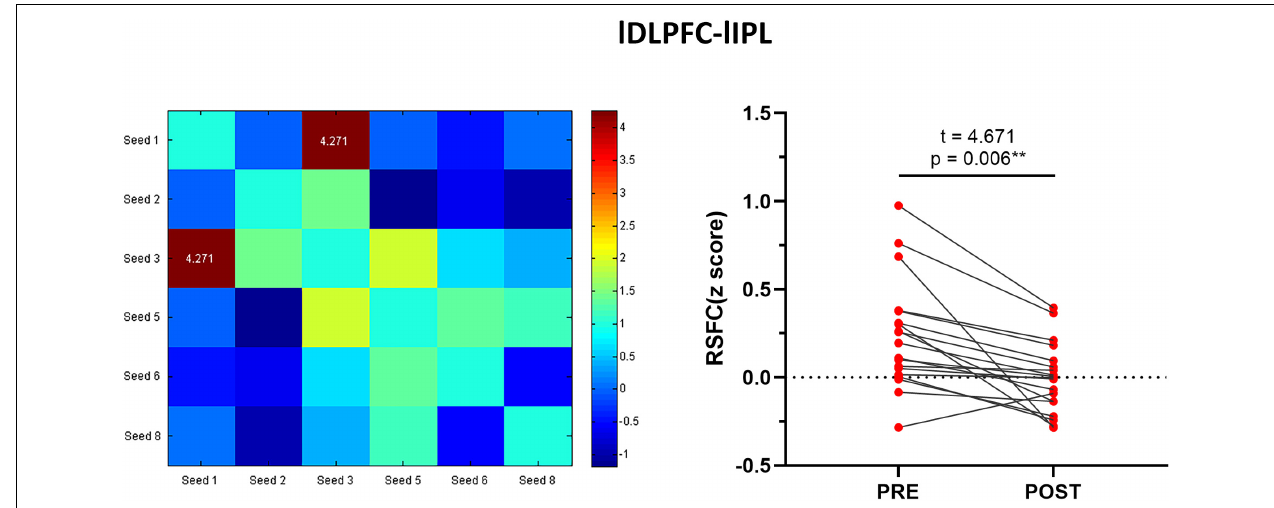
FIGURE 3 | Differences before and after iTBS treatment in the Alzheimer’s Patients in the